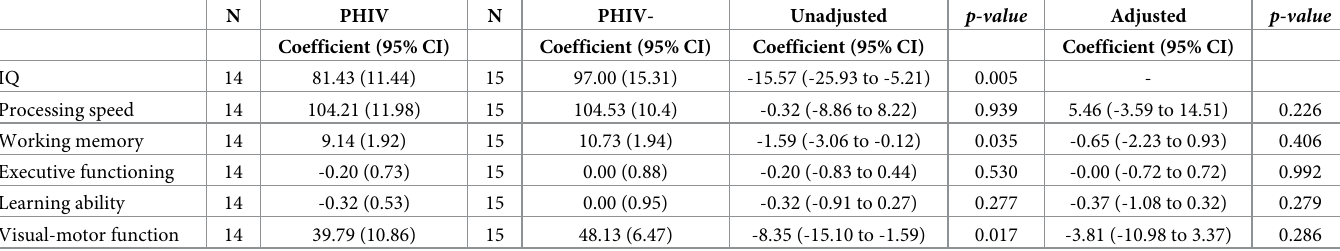
Table 2. Cognitive domain scores in Perinatally Human Immunodeficiency Virus infected (PHIV) and PHIV uninfected (PHIV-) controls.